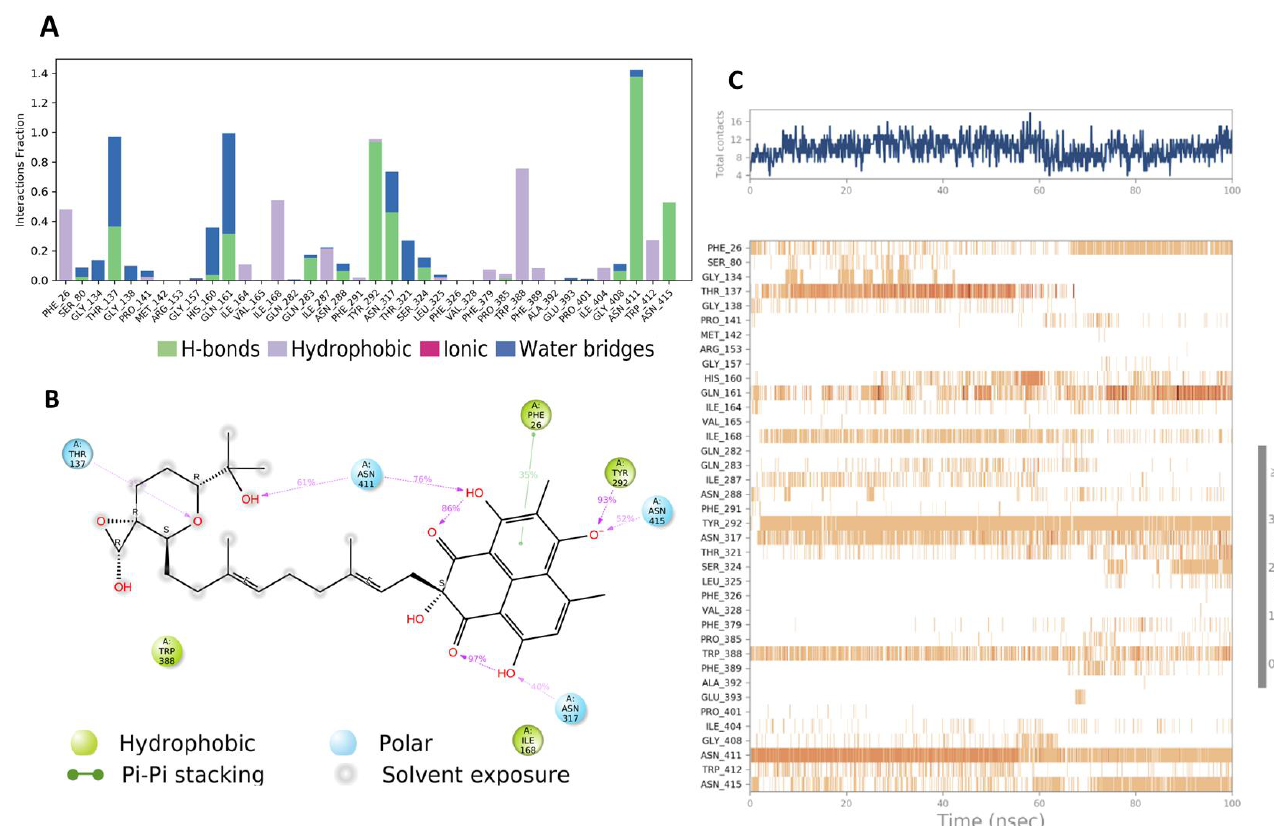
Figure 22. ( A ) The interaction of GLUT1 (PDB: 5EQG) with the native inhibitor 60 throughout the simulation. The interactions between the ligand and protein were classified into hydrophobic, hydrogen bond, ionic, and water bridge interactions. The stacked bar charts were normalized over the course of the trajectory: for example, a value of 0.65 suggested that the interaction with the specific amino acid residue was maintained during 65% of the simulation time. Values over 1.0 implied that some protein residues made multiple interactions of the same subtype with the ligand. ( B ) A schematic diagram showing the detailed 2D atomic interactions of 60 with GLUT1, occurring for > 30% of the simulation time in the selected trajectory (0 through 100 ns). Interactions with > 100% occurrence meant that residues may have multiple interactions of a single type with the same ligand atom. ( C ) A timeline representation of the GLUT1- 60 interactions shown in ( A ). The panel on top illustrates the total number of specific interactions that the protein has made with the compound over the course of the trajectory. The panel below illustrates which residues interacted with the ligand in each trajectory frame. The dark or orange color indicates that more than one specific interaction was made between some residues and the